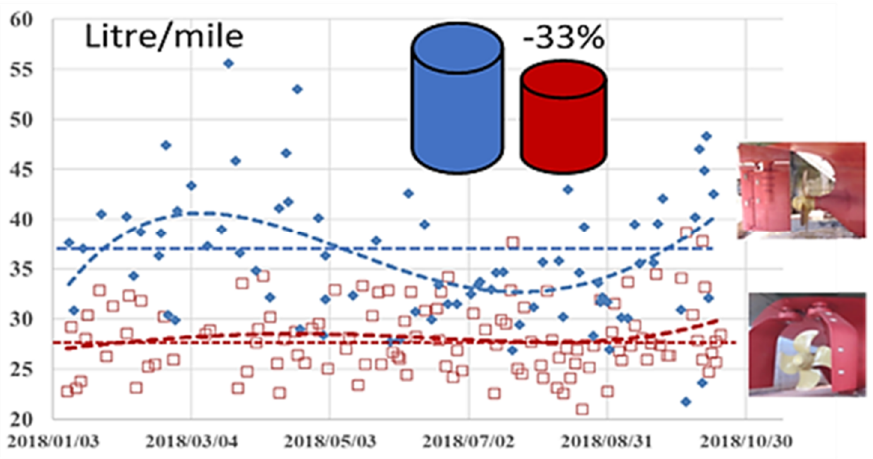
Figure 4. In-service fuel consumption comparisons of two sister ships, Shigenobu with GRS (red) and Sakura with CRS (blue).